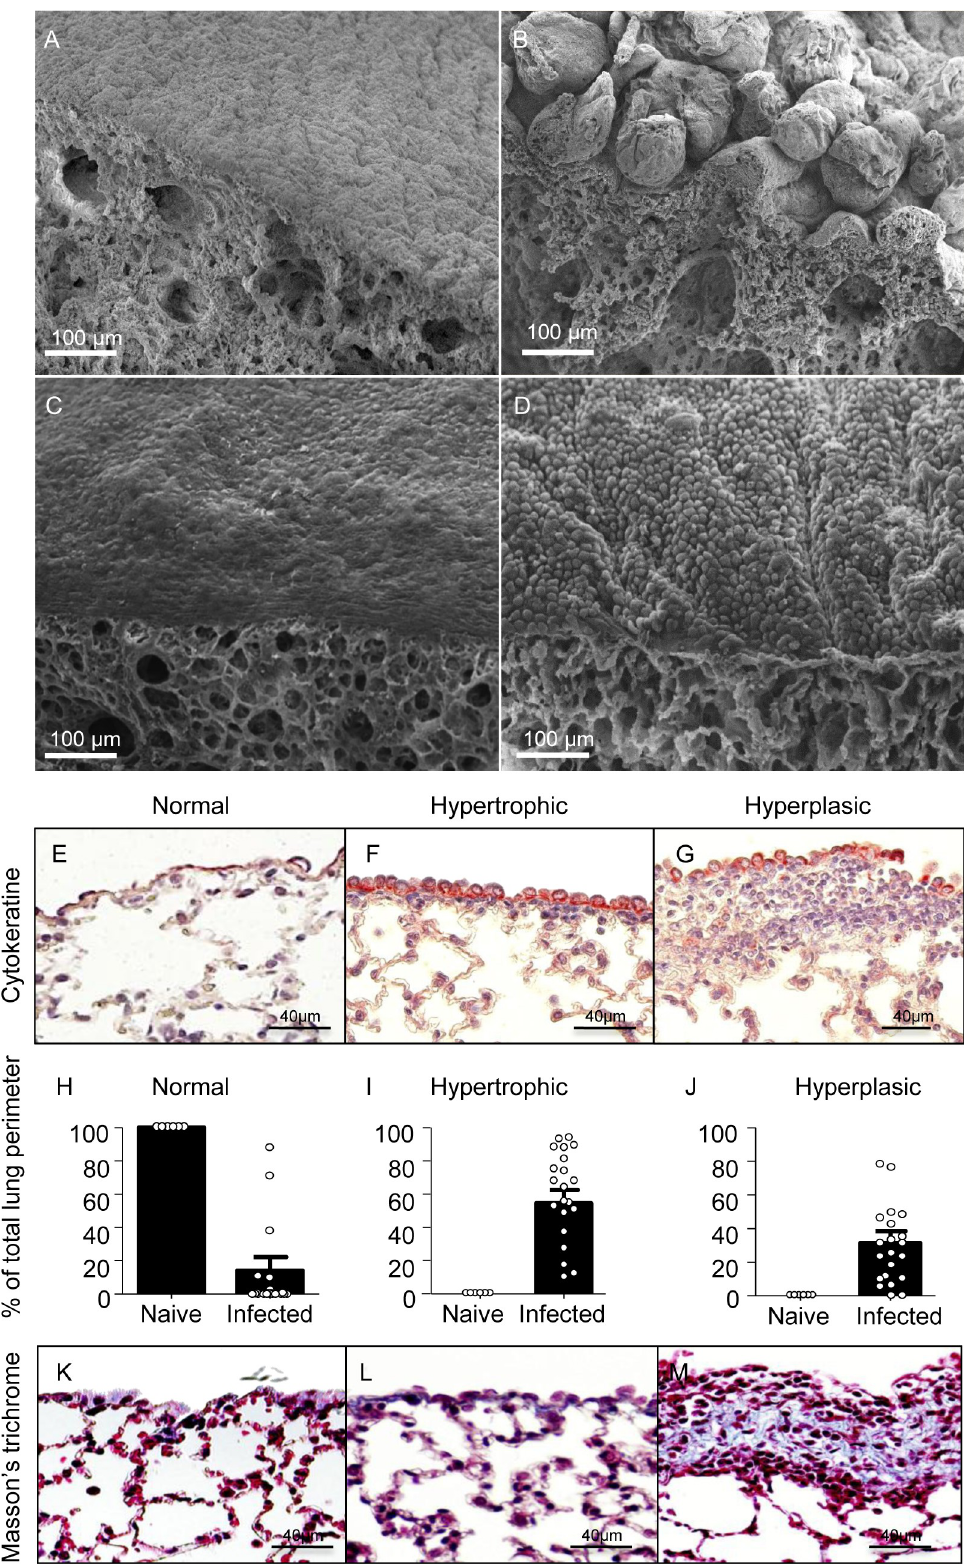
Fig 1. Visceral pleura pathology and fibrosis in rodent lungs during chronic filarial infection. ( A-B ) Jirds infected with L . sigmodontis were euthanized 6 months p.i., and lungs were recovered and prepared for scanning